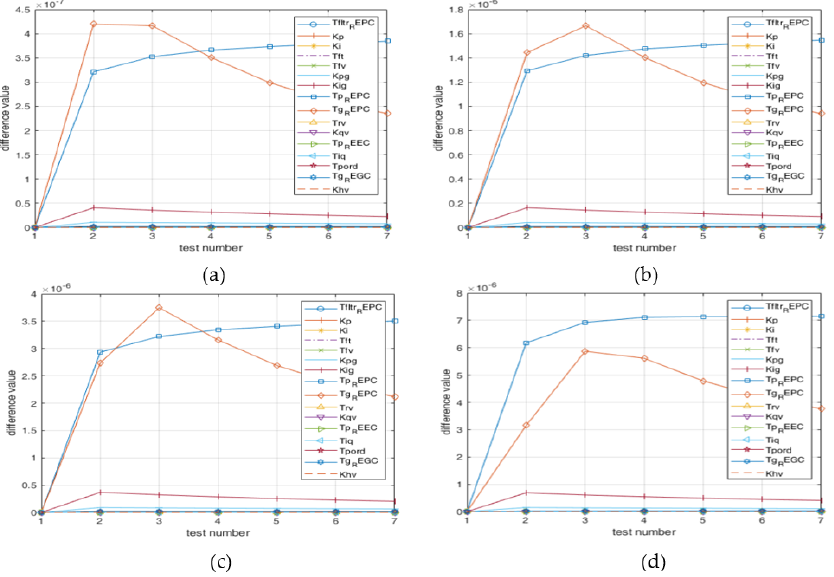
Figure 16 . The parameters of the input active power step . ( a ) P = 0.2 p.u., ( b ) P = 0.4 p.u., ( c ) P = 0.6 p.u., and ( d ) P = 0.8 p.u .